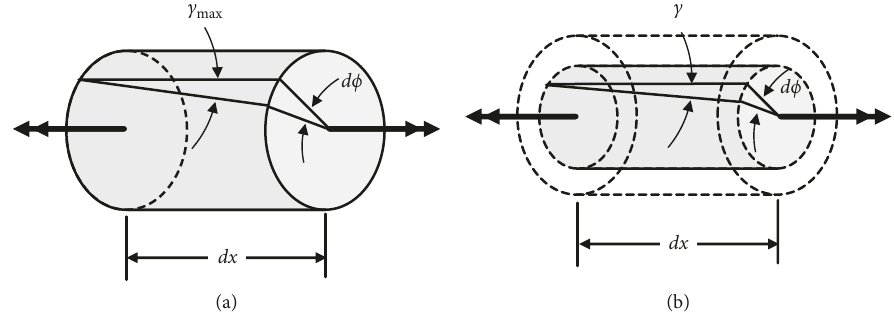
Figure 4: Linear distribution of (a) shear strain in longitudinal direction and (b) angle of twist in radial directions.